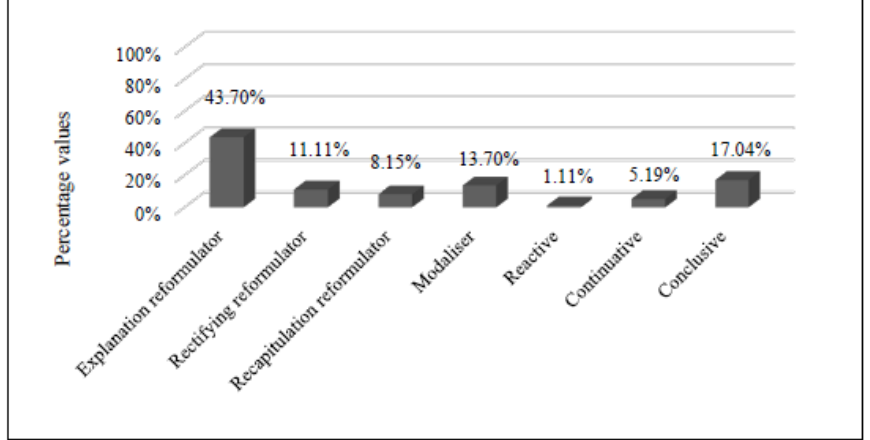
Figure 2. Pragmatic functions of vamos in the PRESEEA corpus of Granada.